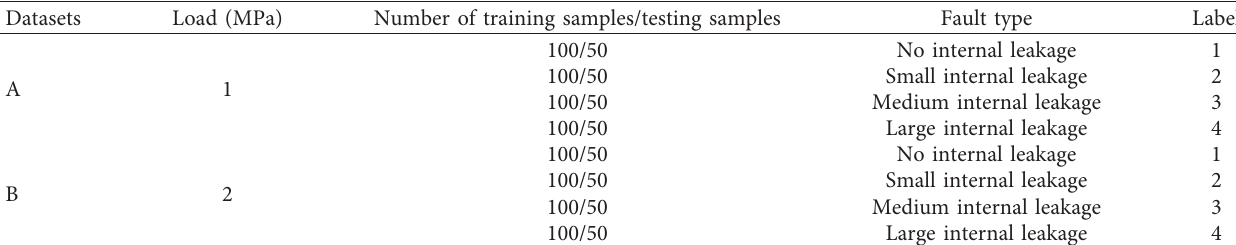
Figure 6: AE signals under a load of 2MPa in four different internal leakage states. Table 1: Sample distributions under four different